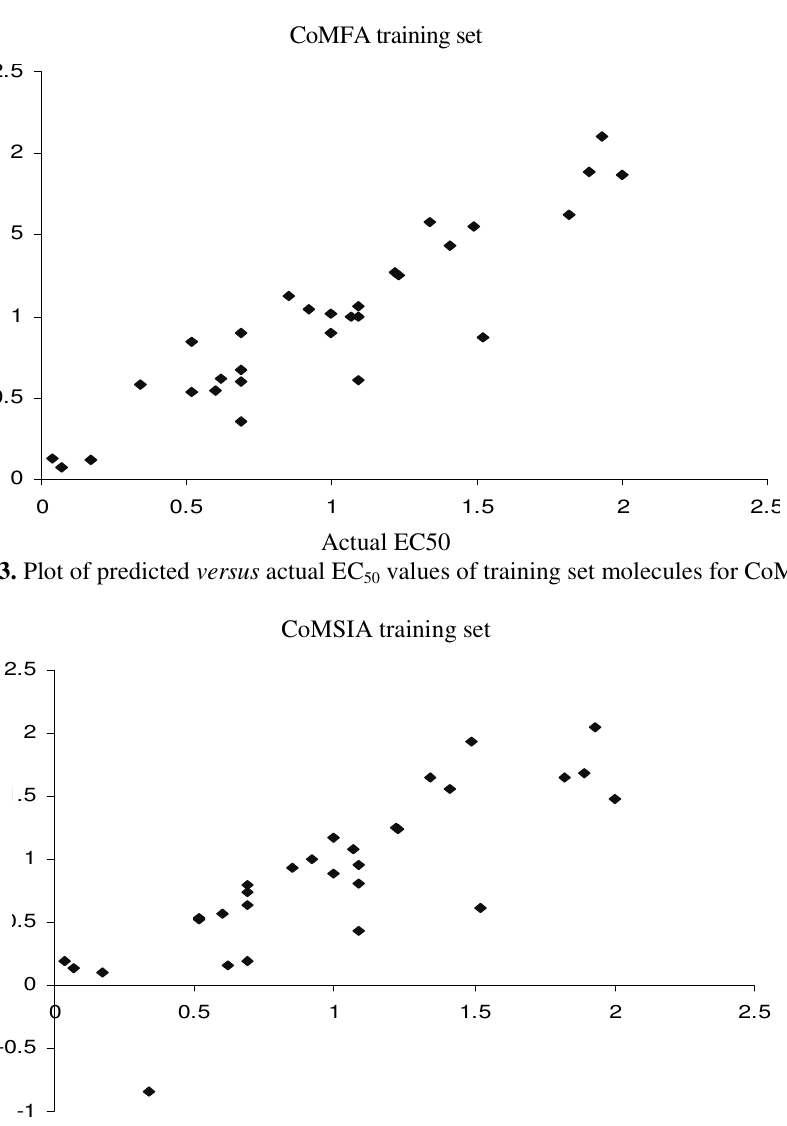
Figure 4. Plot of predicted versus actual EC